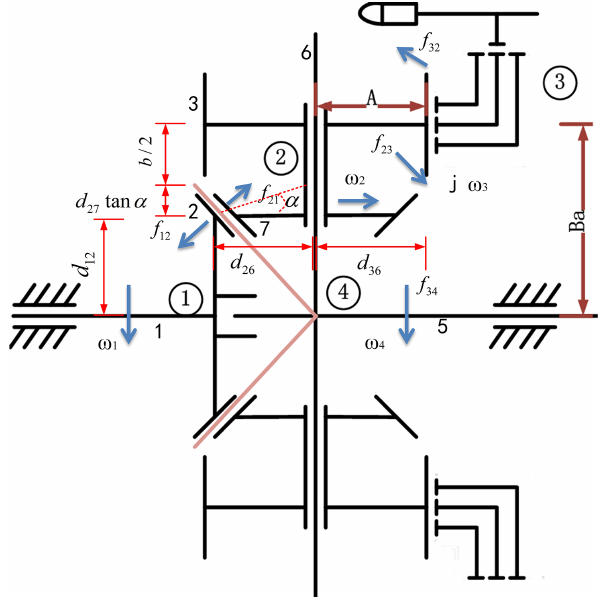
Figure 1. Transmission schematic about planetary transmission